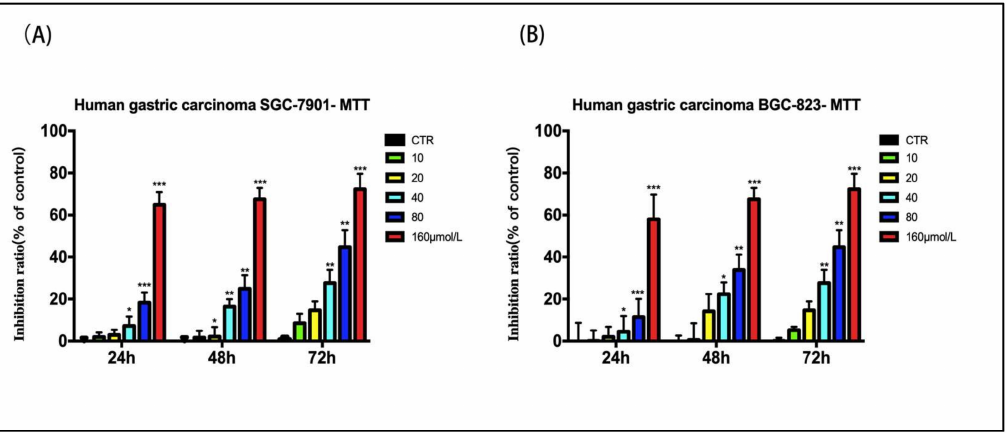
Figure 2. ( A ) Growth inhibitory e ff ects of 28-hydroxy-3-oxoolean-12-en-29-oic acid on SGC-7901. ( B ) Growth inhibitory e ff ects of 28-hydroxy-3-oxoolean-12-en-29-oic acid on BGC-823. Cells were treated with various concentrations of 28-hydroxy-3-oxoolean-12-en-29-oic acid (10, 20, 40, 80 and 160 µ mol / L) for 24 h, 48 h and 72 h, and cell viability was assessed by an MTT (thiazole blue)